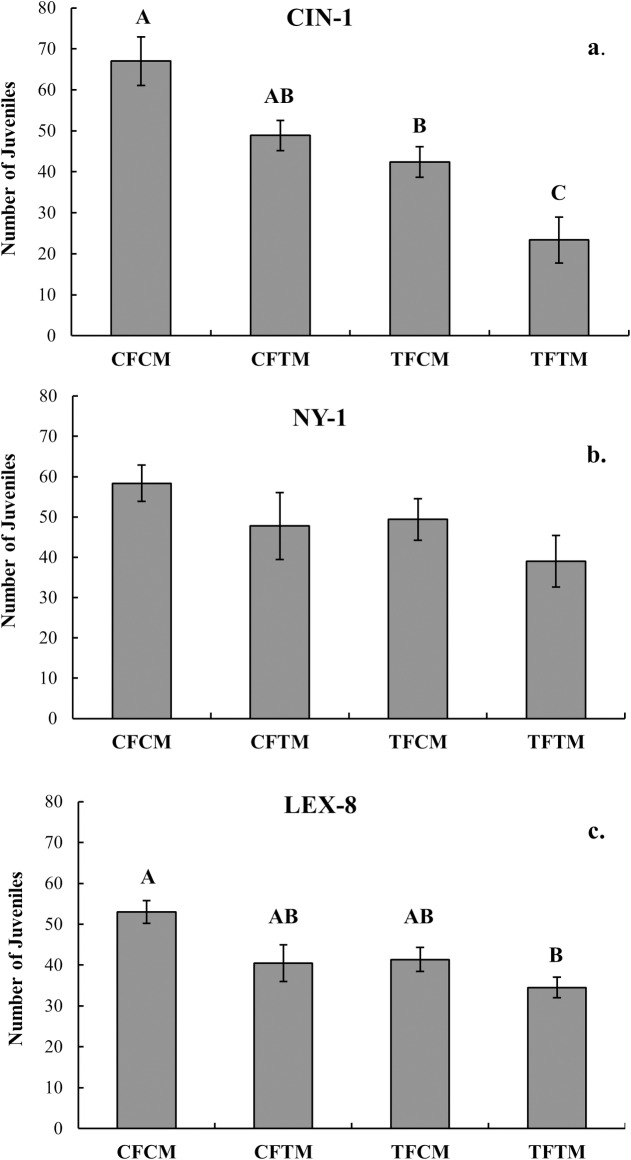
Characterization of successful egg hatch when sublethal exposure occurred before mate pairing.The number of hatched eggs (obtained by counting the number of juvenile bed bugs present) in all four combinations of treated and control males and females is presented (CF = Control Female, CM = Control Male, TF = Treated female, TM = Treated Male). Insecticide treatment via sublethal exposure (LT10) to the label rate of Temprid had a significant impact on the number of hatched eggs over the six week evaluation in two of three strains (ANOVA followed by Tukey HSD). When treatment groups share letters in common they are not significantly different (Tukey HSD test with α = 0.05). There was a steep decline in viable egg production when both male and female bed bugs in the mating pair had sublethal exposure (LT10) to insecticide, and an intermediate reduction in viable eggs when either the male or the female (but not both) experienced sublethal exposure. NY-1 (the moderately resistant strain) showed no significant reduction in the number of hatched eggs in this experiment.